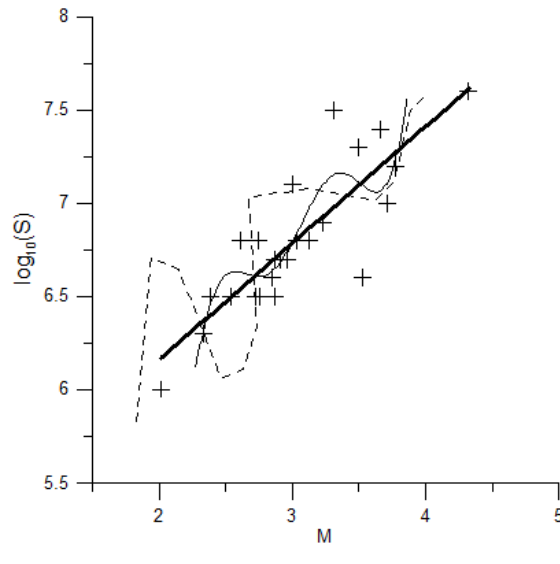
FIG.9 Fig. 9. Relationship between logarithmic isoseismal area and earth- quake magnitude estimated by the back propagation NN (dashed curve) and the proposed hybrid fuzzy-neural methodology (solid curve). The lines corresponds to the list square fit of the